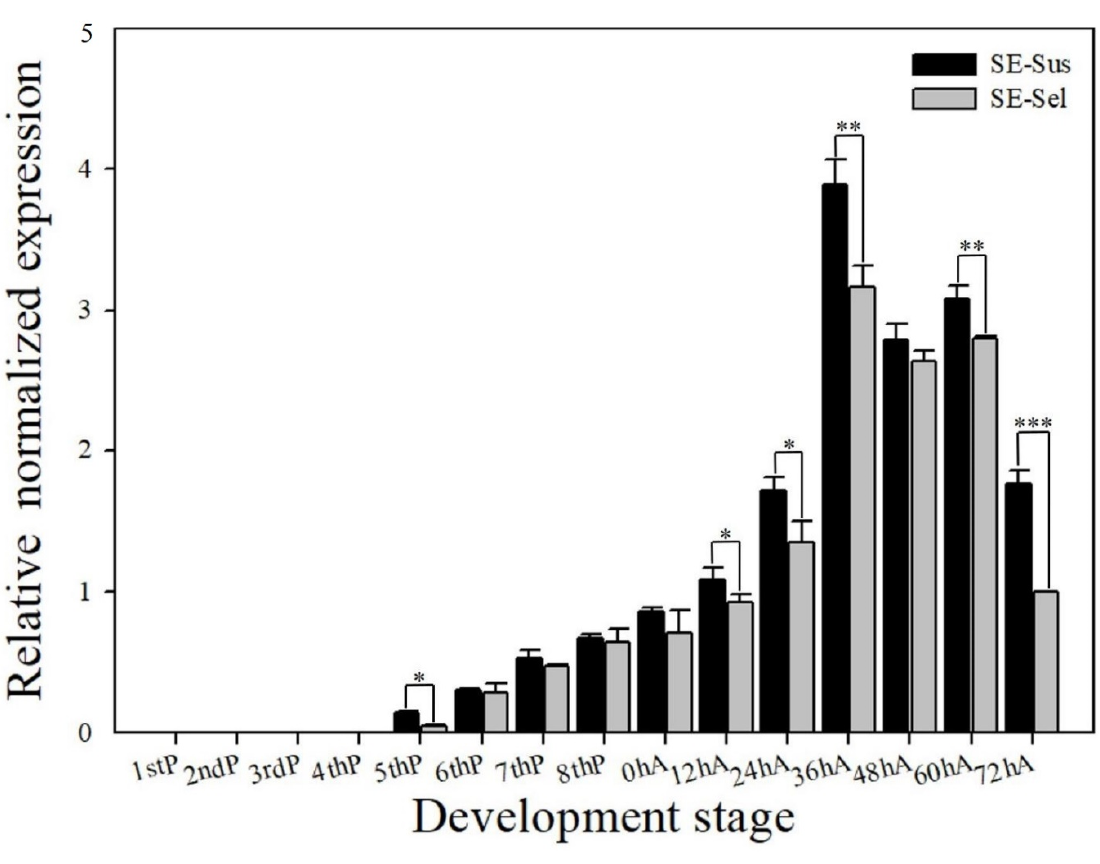
Figure 2. The relative normalized expression of the SeVg gene at different development stages of in the SE-Sus and SE-Sel strains. 1stP, 2ndP, 3rdP, 4thP, 5thP, 6thP, 7thP, and 8thP indicate 1 to 8 days after pupation, respectively. 0 hA, 12 hA, 24 hA, 36 hA, 48 hA, 60 hA, and 72 hA indicate 0 to 72 h after emergence, respectively. Different letters (a, b) above bars indicate significant differences ( p < 0.05) according to Tukey’s multiple range test. Different numbers of asterisks indicate significant differences at different levels (* means p < 0.05, ** means p < 0.01, *** means p < 0.001).